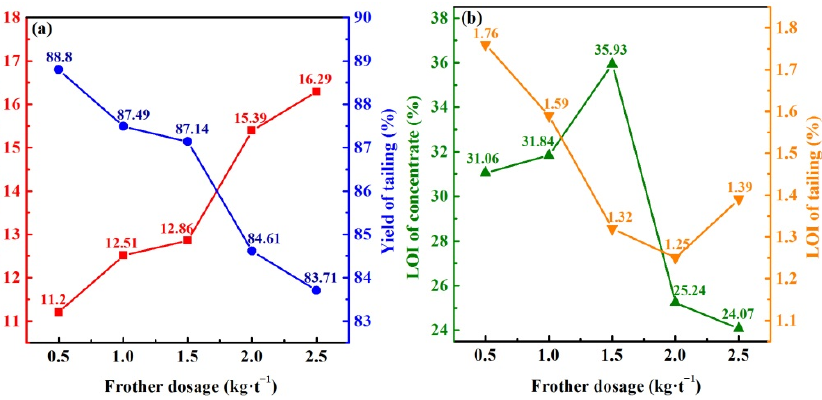
Table 2. Effect of frother types on the flotation performance of FEBFS samples.